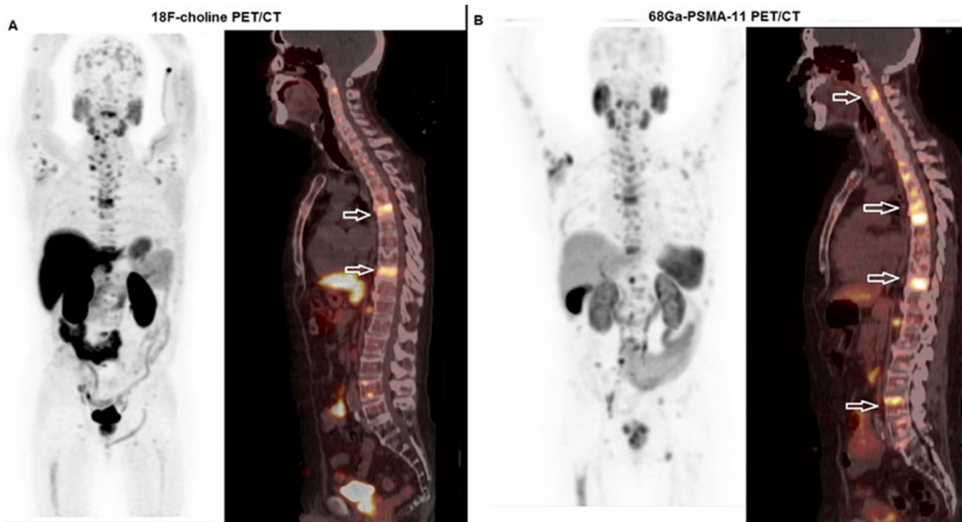
Figure 2. A 71-year-old man affected by prostate cancer, diagnosed in 2009 and submitted to prostatectomy (Gleason score 4 + 3, ISUP 3, pT2 pN0). After 8 years, progressively increasing values of PSA were registered, and the patient underwent a sequence of therapeutic regimens (antiandrogen deprivation therapy, 2nd generation antiandrogen therapy with enzalutamide, chemotherapy with taxanes). In 2022, due to progressive disease at a skeletal level, he was submitted to PET/CT with 18 F-choline and 68 Ga-PSMA-11 before enrollment for 223 Ra-therapy. ( A ) Whole body (left side) and fused sagittal 18 F-choline PET/CT (right side) demonstrated highly increased tracer incorporation in the thoracic spine (white bordered arrows). ( B ) Whole body (left side) and fused sagittal 68 Ga-PSMA- 11-PET/CT (right side) depicted multiple PSMA-avid lesions in the cervical, thorax and lumbar spine (white arrows). Note that the extension of skeletal involvement shown by 68 Ga-PSMA PET/CT is much more relevant with respect to that demonstrated by 18